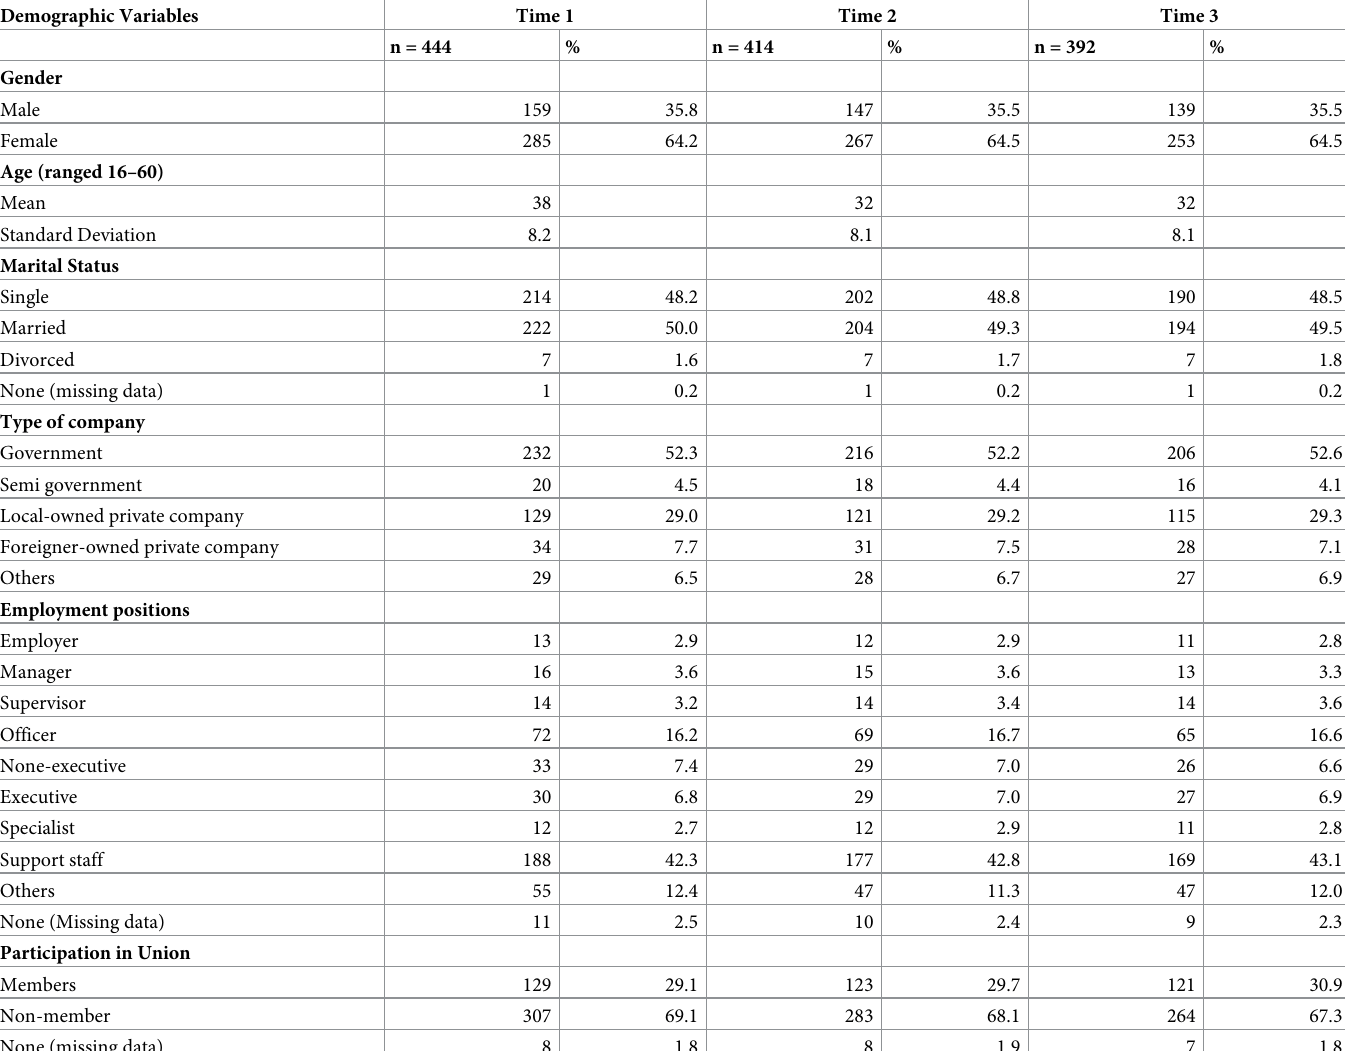
Table 2. Main characteristics of the participants for three-time